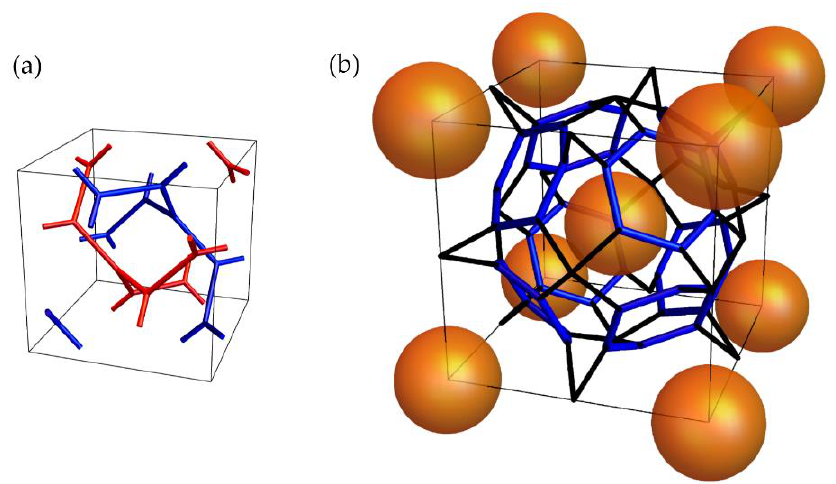
Figure 1. Unit cells of ( a ) a double gyroid cubic phase and ( b ) chiral cubic phase used to model the resonant X-ray response. The double gyroid cubic phase consists of two entangled systems of channels (red and blue). Three channels meet in a planar junction, and the direction normal to the junction rotates in the opposite direction in the two systems of channels. The all-hexagon-continuous grid of a chiral cubic phase consists of eight nonplanar hexagons (blue lines) in which the sides are of the same length as in the double gyroid phase, and hexagons consisting of two sides of the blue hexagons connected to the centers of edges and centers of faces of the cube (black lines). There are micelles in the center and edges of the unit cell. The unit cell side in the 𝐶𝐶 phase is always approximately 50% longer than in the double gyroid phase.